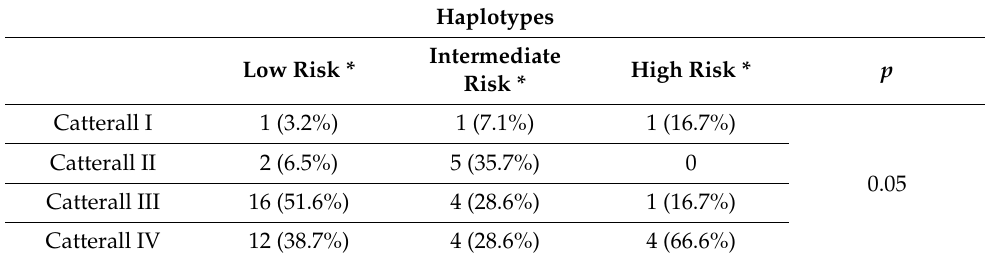
Table 3. Haplotype distributions and the severity of LCPD hips based on Catterall